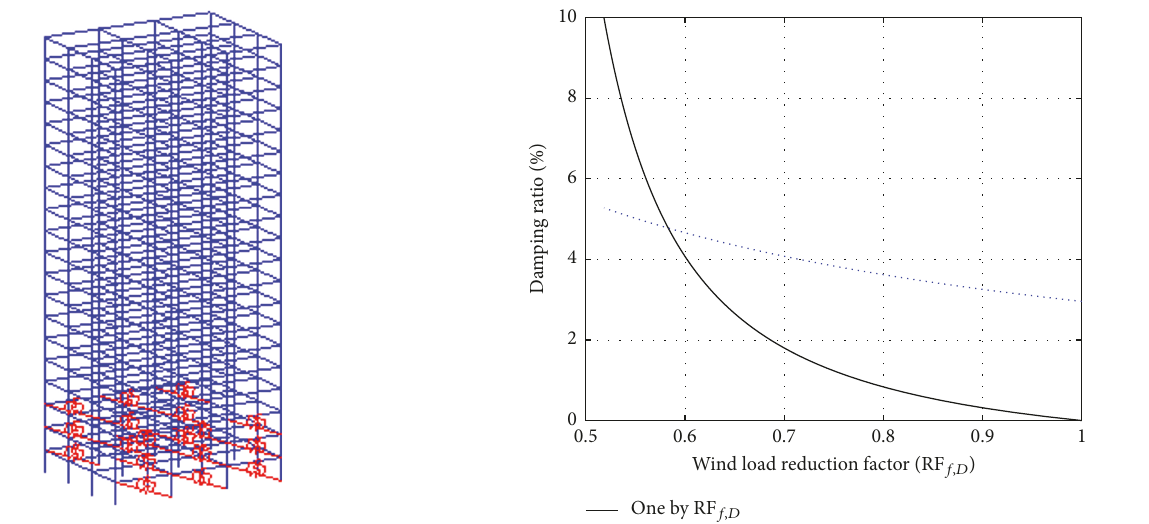
Figure 18: Damper installation configuration in a 20-story steel structure.